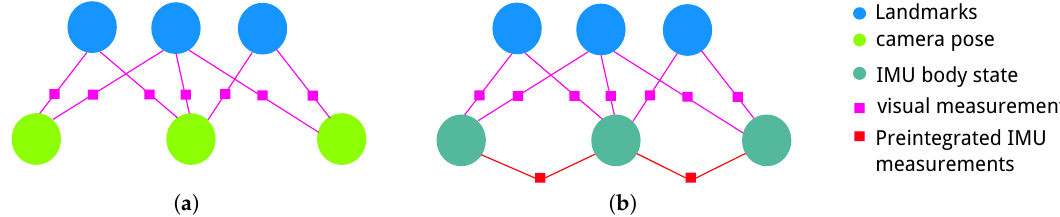
Figure 3. Factor graphs of ( a ) the visual simultaneous localization and mapping (SLAM) problem versus ( b ) visual–inertial